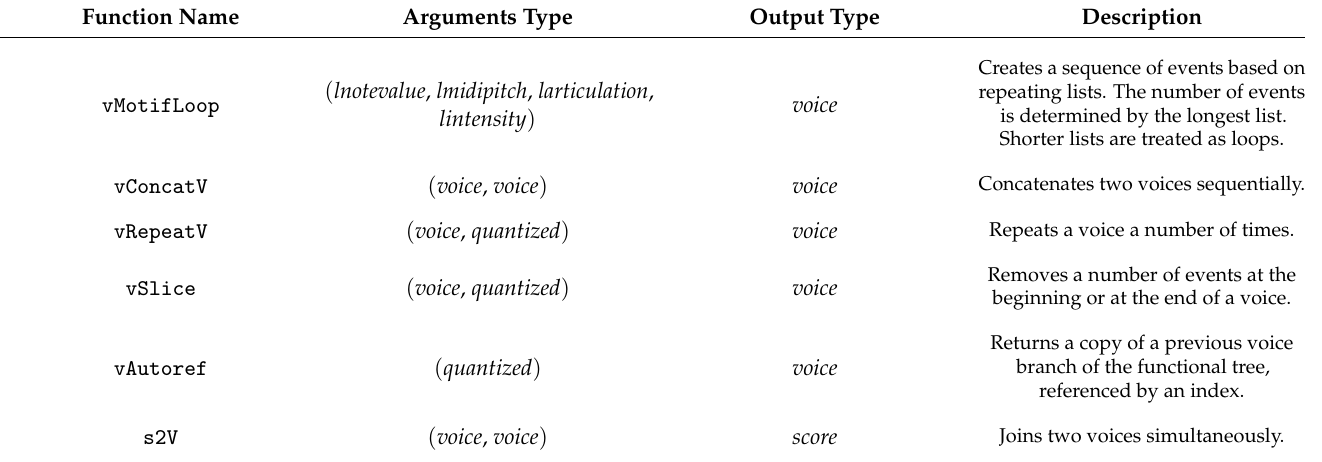
Table 3. Genotype functions used to model Clapping Music . The table shows only functions that are not mere identity functions that act as simple data containers for each parameter type.